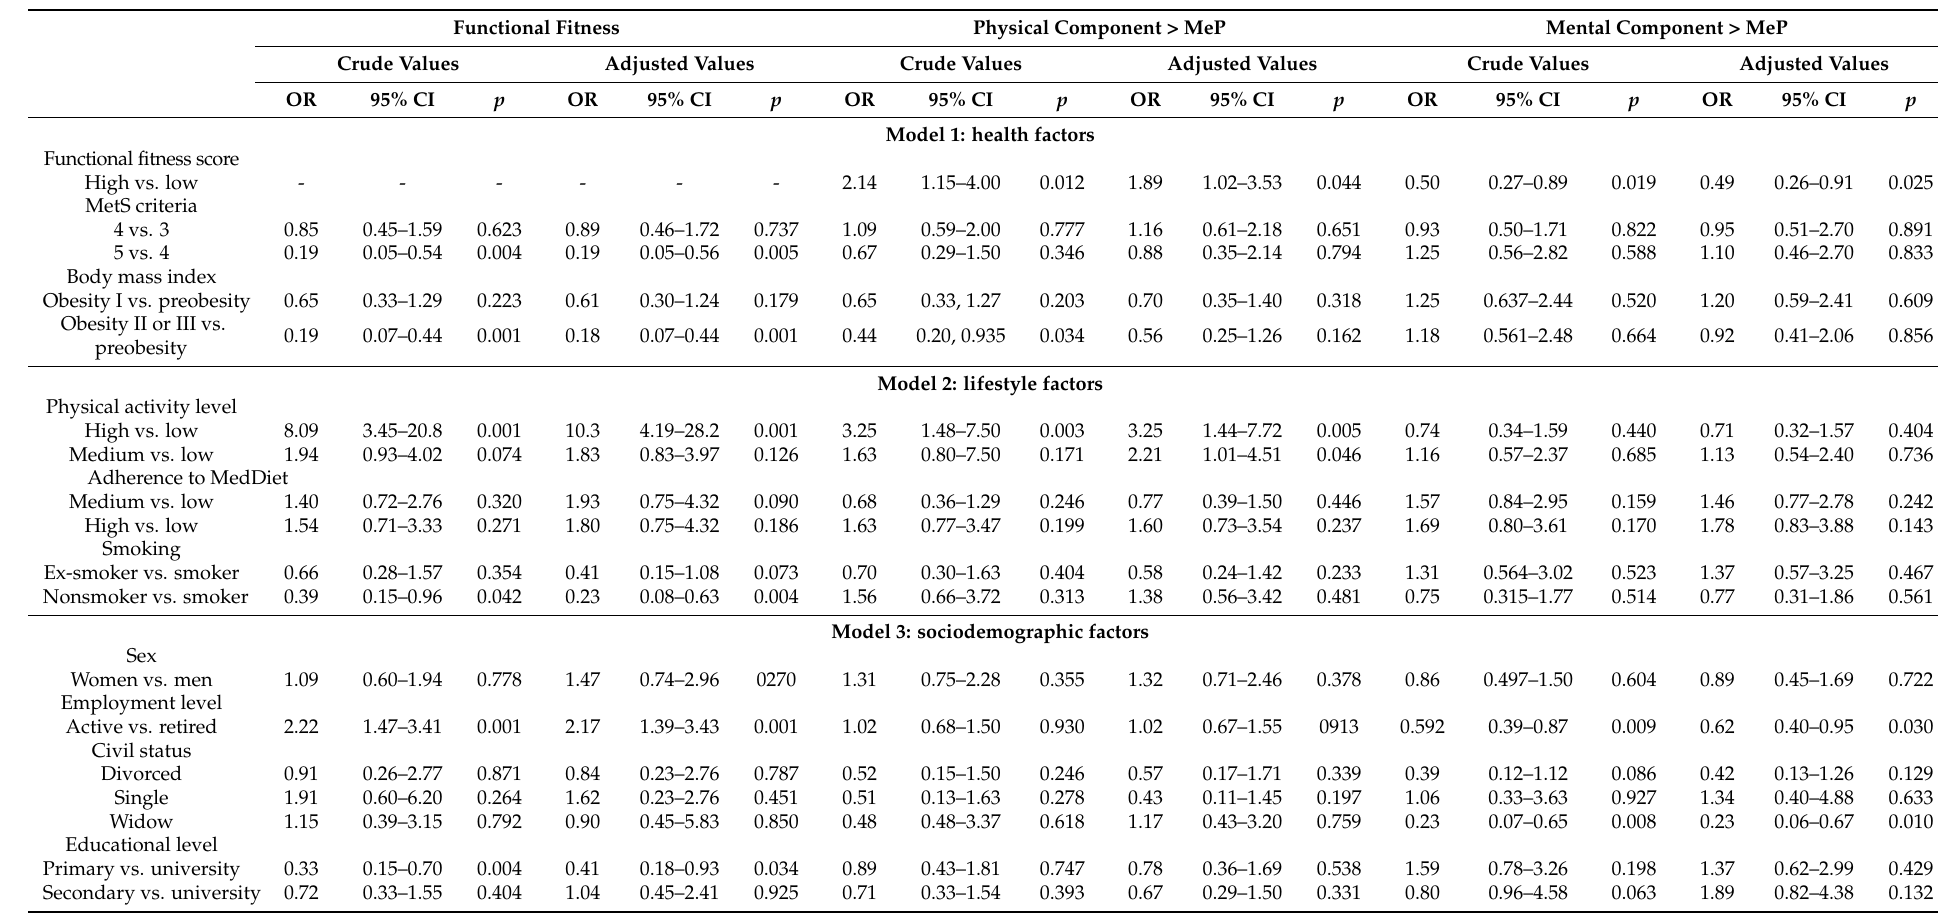
Table 3. Association between health, lifestyle, and sociodemographic factors vs. functional fitness, physical, and mental